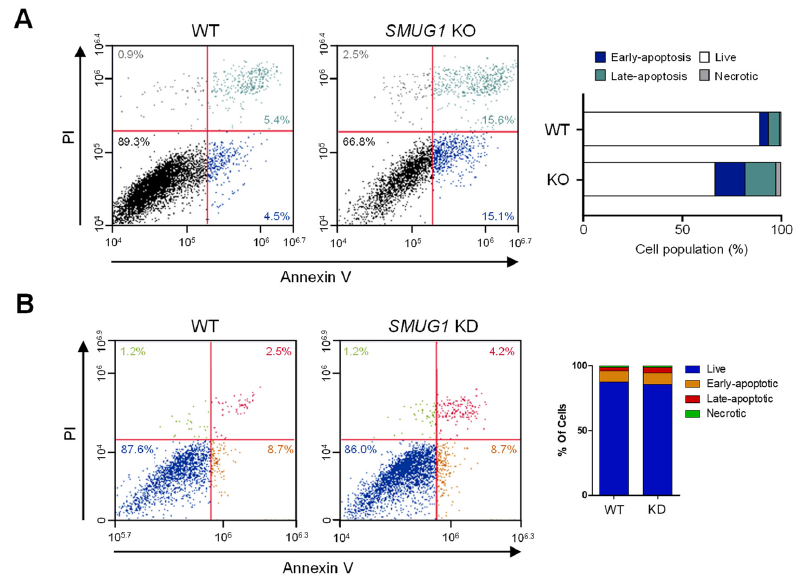
Figure 4. Ablation of SMUG1 induces apoptotic cell death in SMUG1 KO and KD cells. ( A ) Apoptotic